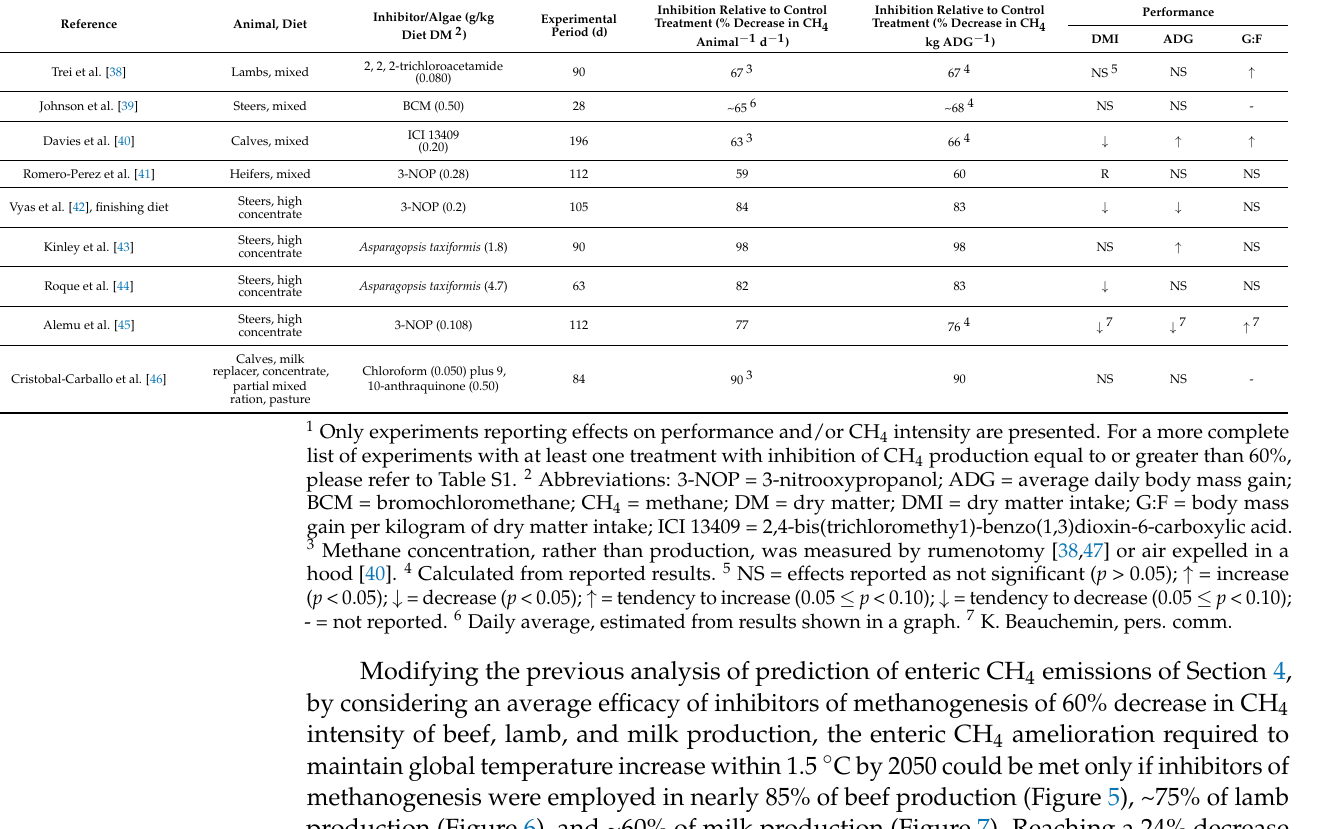
Table 2. In vivo growth and fattening experimental treatments resulting in 60% or greater decrease in enteric methane (CH 4 ) production 1 .